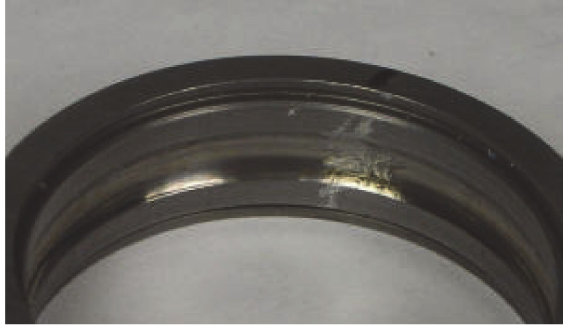
Figure 7. Outer race